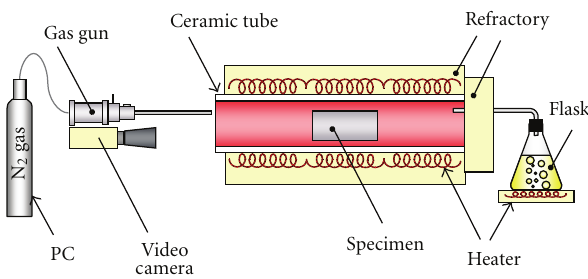
Figure 1: Schematic illustration of furnace and a gas gun.